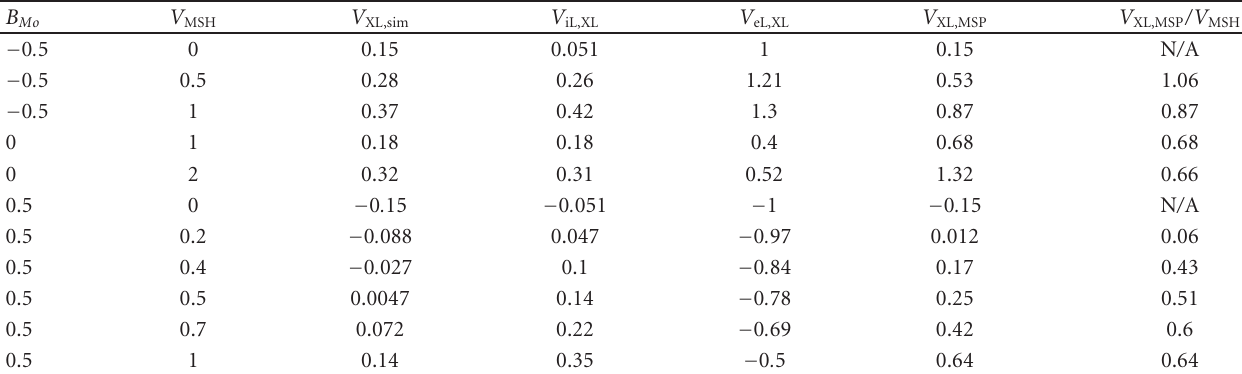
Table 2: Summary of all the cases studied in this paper. B Mo : guide field, V MSH : velocity jump across the magnetopause, V XL,sim : the X -line speed measured in the simulation frame, V iL,XL : the L -component of the ion flow at the X -line, V eL,XL : the L -component of the electron flow at the X -line, and V XL,MSP : the X-line speed in the magnetosphere-rest